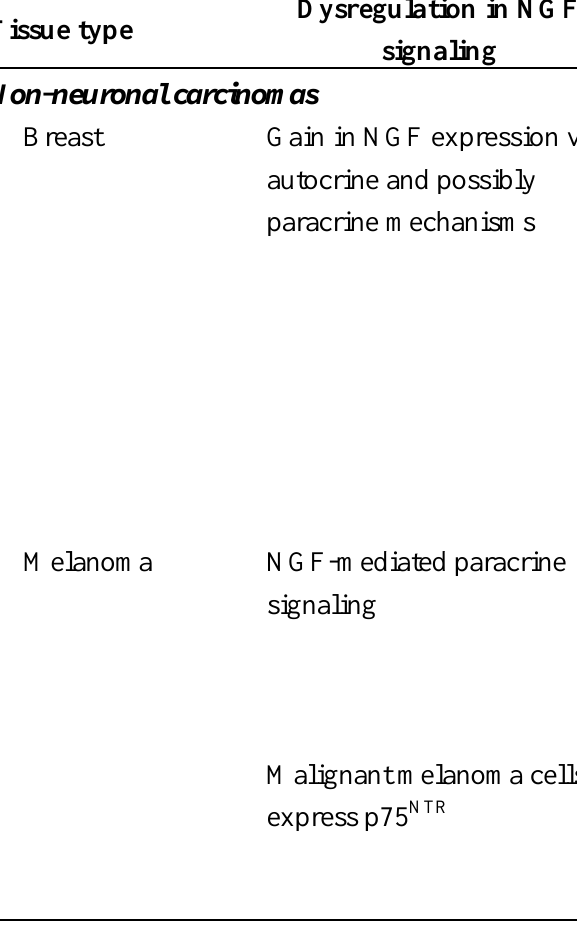
Table 1. Dysregulation of nerve growth factor (NGF) signaling in different cancers.